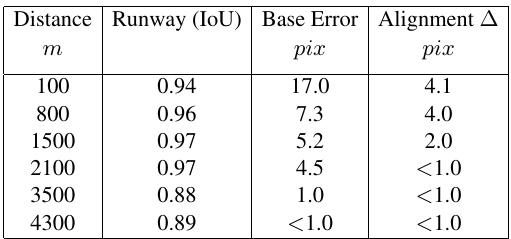
Table 3. IoU metric and object contour alignment accuracy for different distances to the